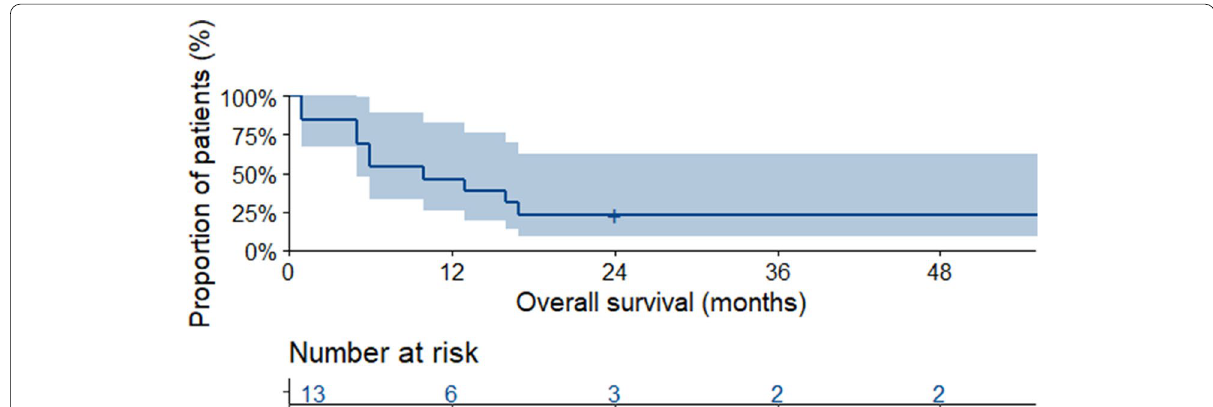
Fig. 1 The survival analysis of the 13 patients with available survival